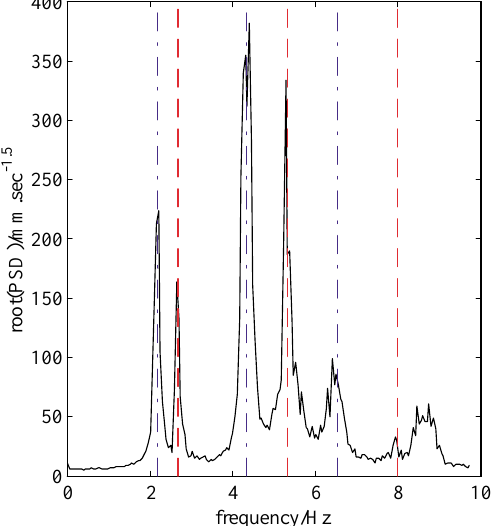
Fig. 12. Floor response to fast jumping by a large crowd-with seated